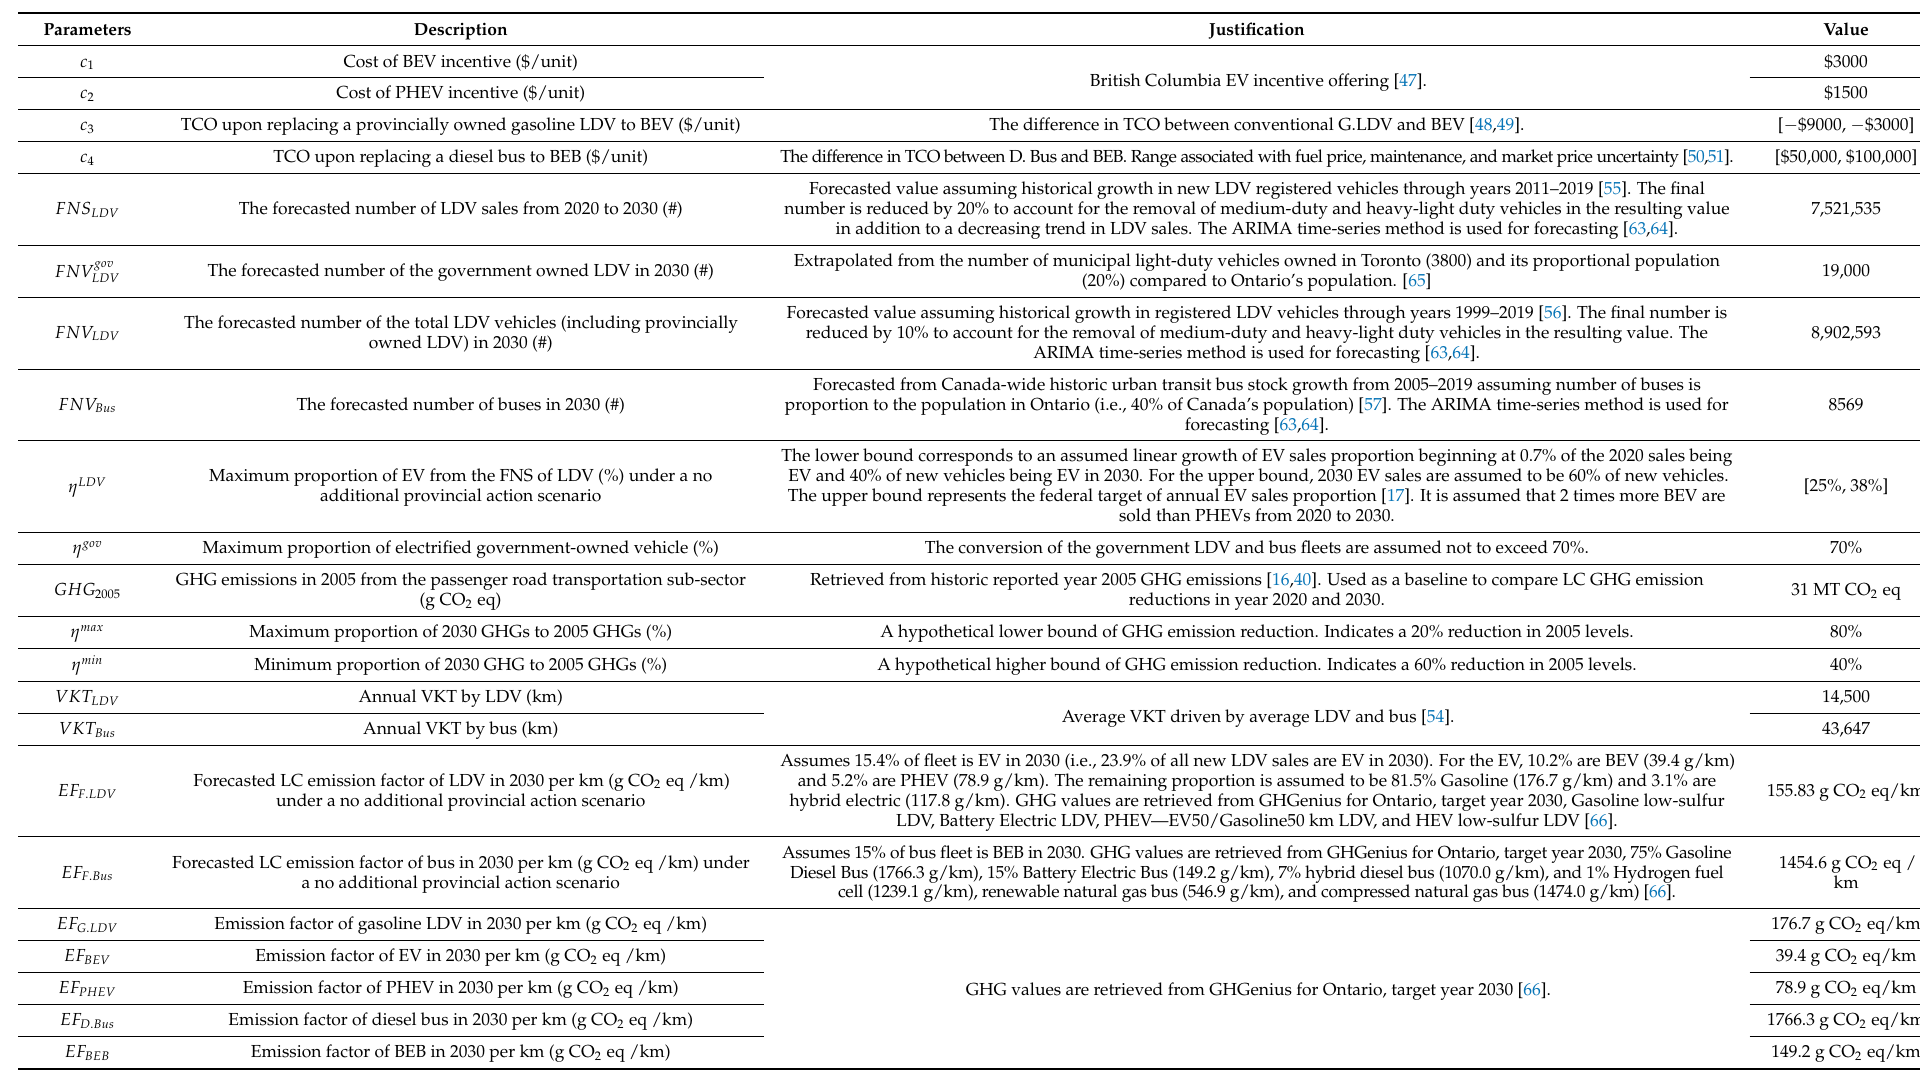
Table 2. Parameters and associated justification for MIO